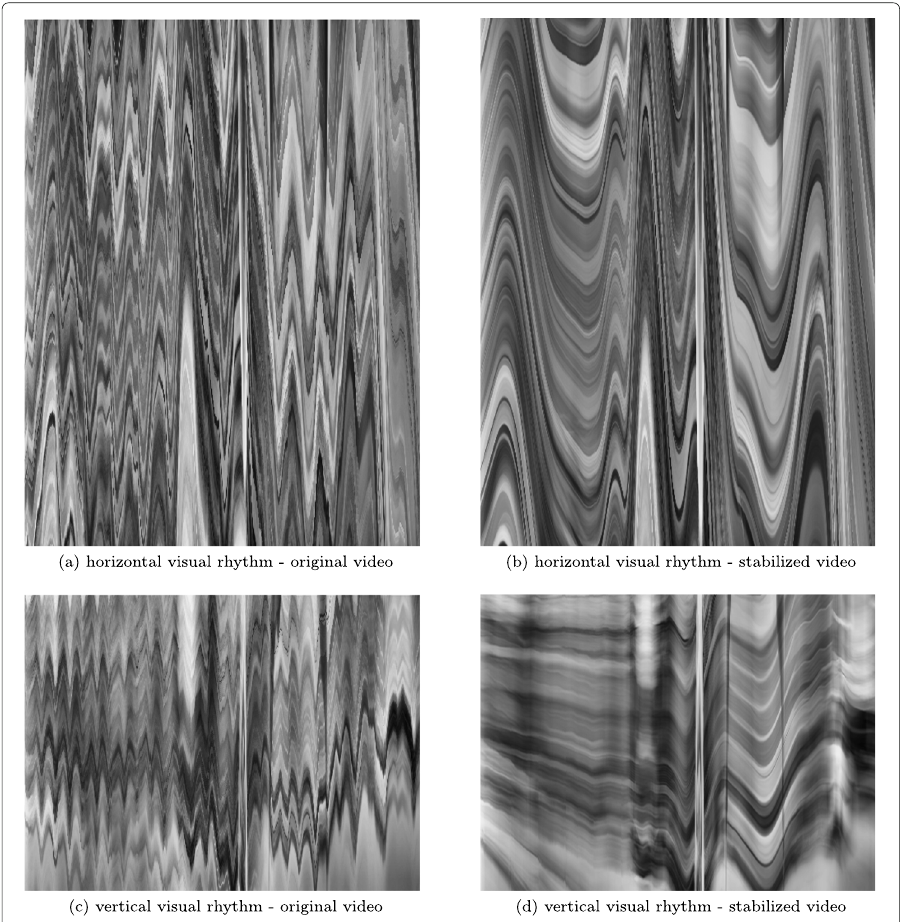
Fig. 10 Visual rhythms for video #12 . a Horizontal visual rhythm for original video. b Horizontal visual rhythm for stabilized video. c Vertical visual rhythm for original video. d Vertical visual rhythm for stabilized